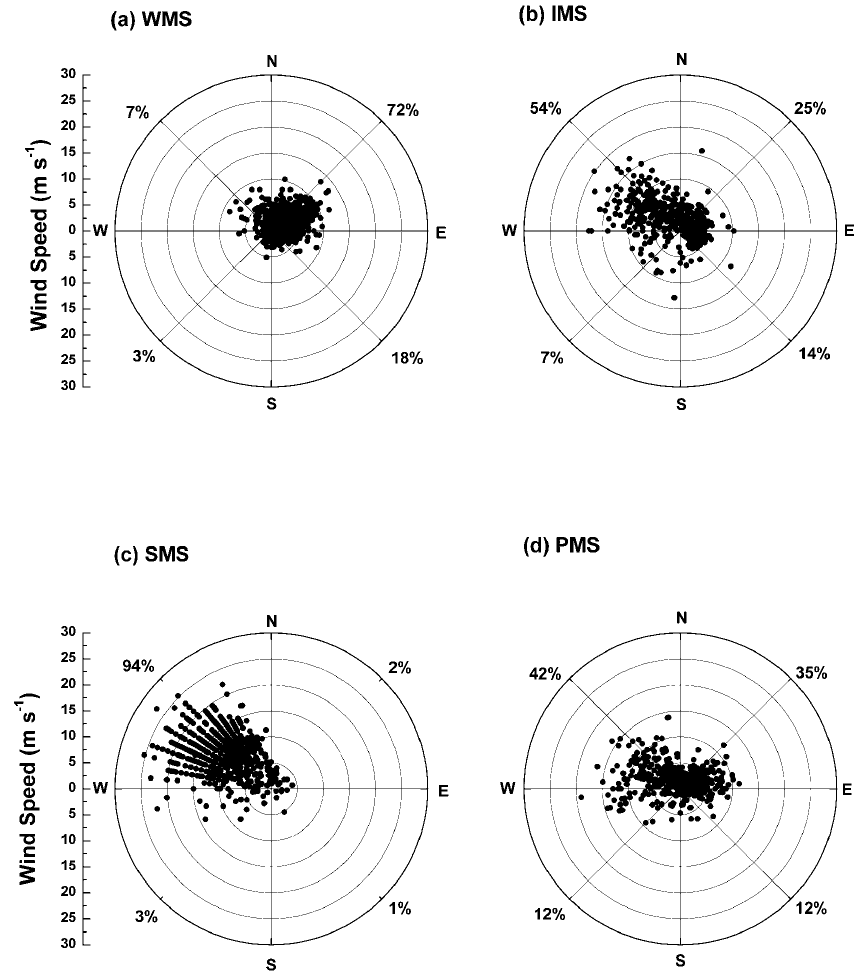
Figure 3. Polar graphs showing wind speed and wind direction for (a) Winter Monsoon Season (WMS; months of December through March) (b) Inter Monsoon Season (IMS; April and May), (c) Summer Monsoon Season (SMS; June through September) and (d) Post Monsoon Season (PMS; October and November). Wind direction refers to the direction of wind arrival. The percentage indicates the percentage of points located in a given quadrant. The clear transformation from WMS to SMS is easily discernible.